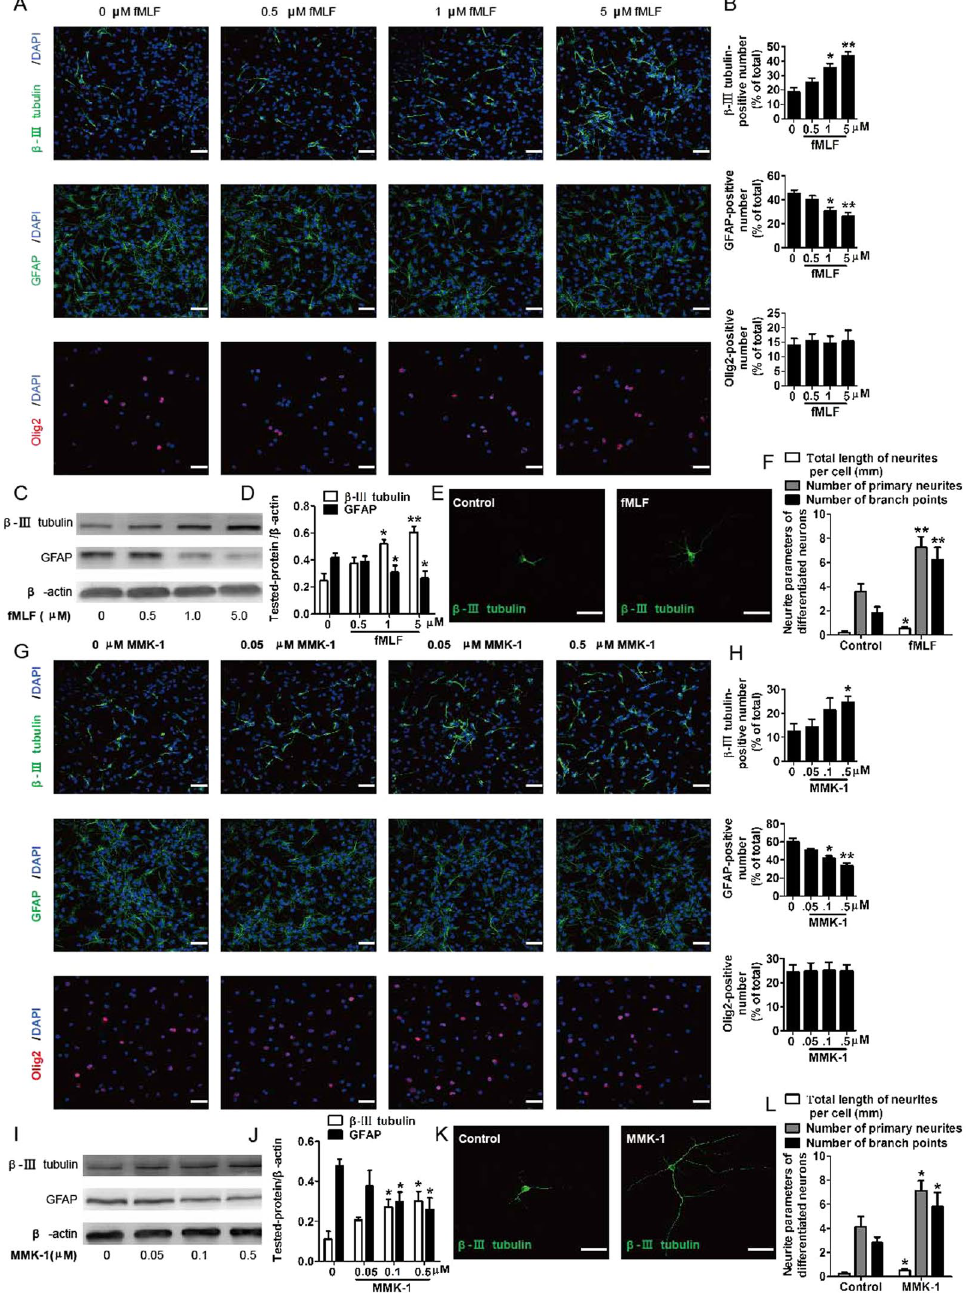
Figure 2. FPRs promoted neuronal differentiation of NSCs. ( A–F ) FPR1 promoted neuronal differentiation of NSCs. ( A,B ) Neurospheres were dissociated into single cells and cultured in a differentiation medium with 0, 0.5, 1, and 5 µ M fMLF for 6 days. The differentiated cells were then identified by immunocytochemistry using antibodies against β -III tubulin, GFAP, and Olig2. The images in ( A ) are representative of several independent experiments, and the graph in ( B ) shows the statistical results. ( C ) Representative immunoblots. ( D ) Histograms showing relative levels of β -III tubulin and GFAP. ( E ) Dissociated NSCs were differentiated in an extremely low density (500 cells/cm 2 ), and then the cells were immunostained with β -III tubulin. ( F ) Quantified analysis of the total length of neurites per cell, the number of primary neurites, and the number of branch points. ( G–L ) FPR2 promoted neuronal differentiation of NSCs. ( G,H ) Neurospheres were dissociated into single cells and cultured in a differentiation medium with 0, 0.05, 0.1, and 0.5 µ M MMK-1 for 6 days. The images in ( G ) are representative of several independent experiments, and the graph in ( H ) shows the statistical results. ( I ) Representative immunoblots. ( J ) Histograms showing relative levels of β -III tubulin and GFAP. ( K ) Representative micrographs of the differentiated cells immunostained with β -III tubulin. ( L ) Quantified analysis of the total length of neurites per cell, the number of primary neurites, and the number of branch points. Data were presented as mean ± SEM. * P < 0.05; ** P < 0.01; N = 4. Scale bar = 20 µ